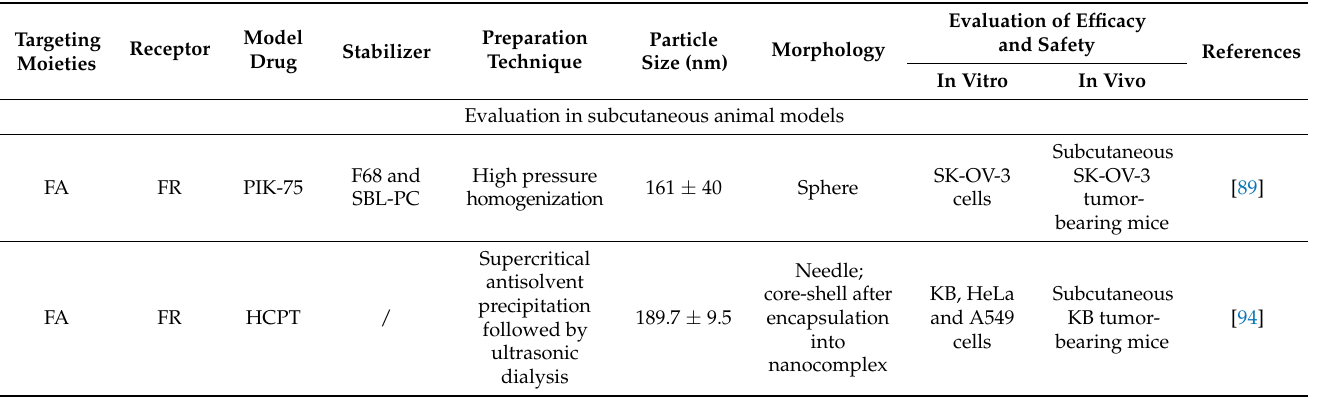
Table 2. Current research on active tumor-targeted drug NCs delivery systems conducted both in vitro and in